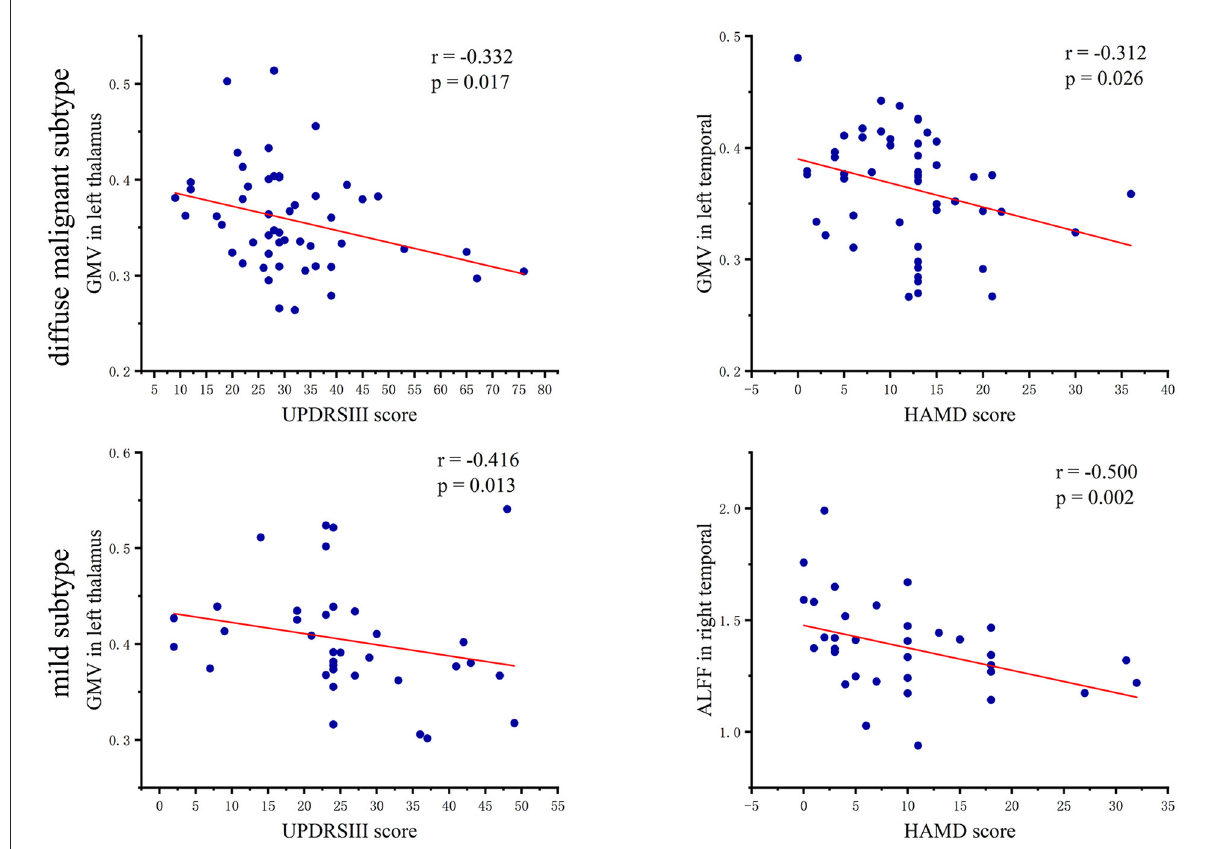
FIGURE4 Scatter plot of correlation coefficient between PD subtypes and clinical symptoms.